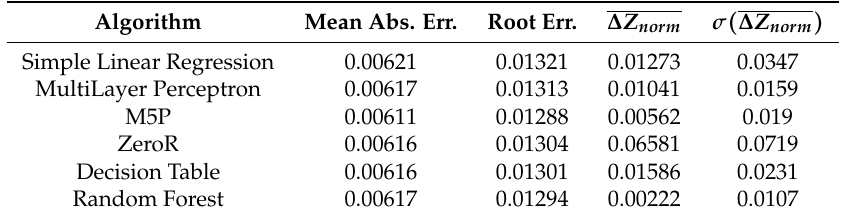
Table 4. The 10-fold cross-validation performance of the different machine learning methods on a set of 20,000 galaxies using the KBestMod feature set.